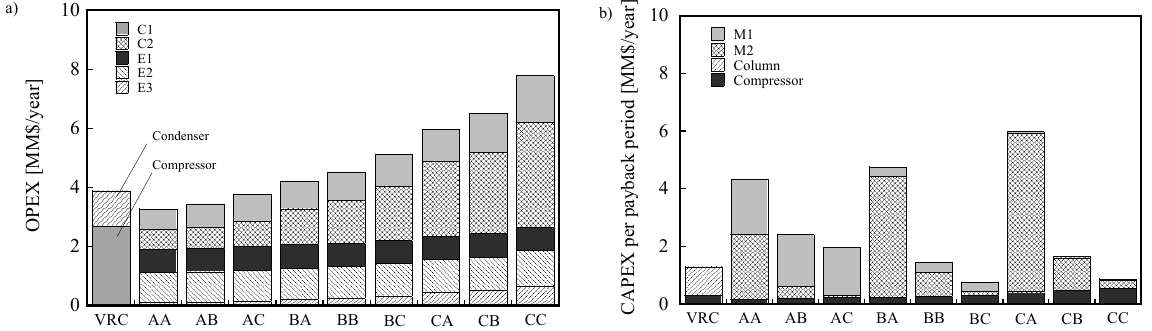
Figure 6. The production cost of the two-stage membrane process with various combinations: ( a ) OPEX and ( b ) CAPEX per payback period. The payback period = 4 y.